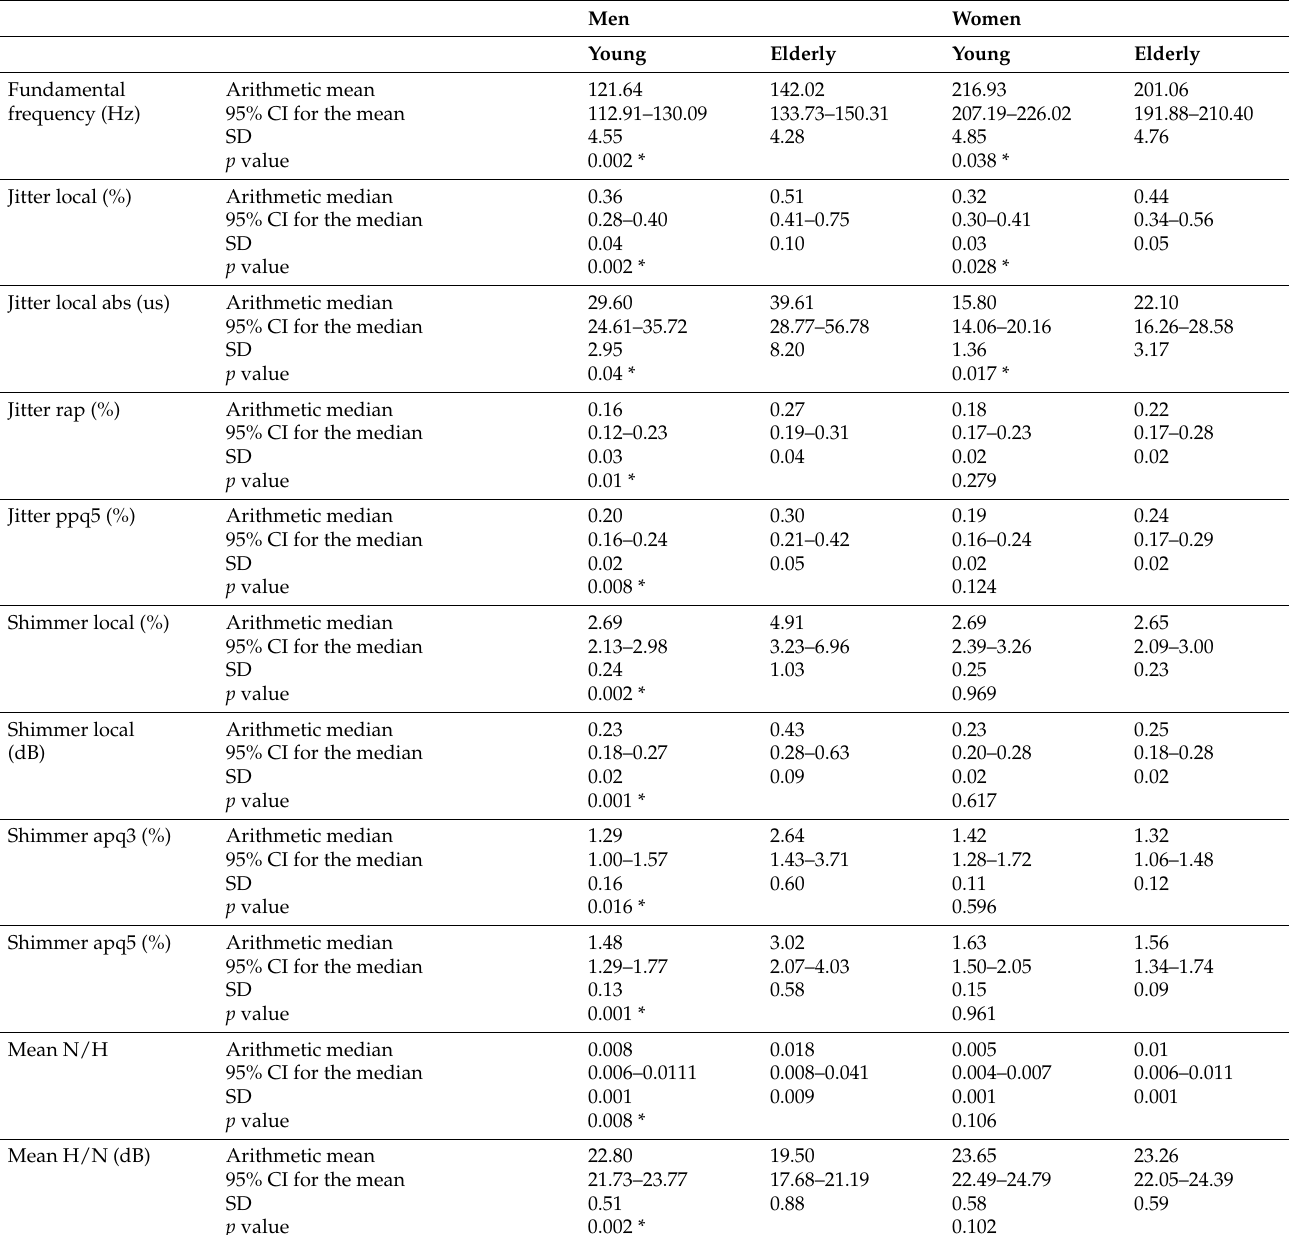
Table 1. Means, 95% confidence intervals (CIs) for the mean and median, and standard deviations (SDs) for all parameters analyzed with